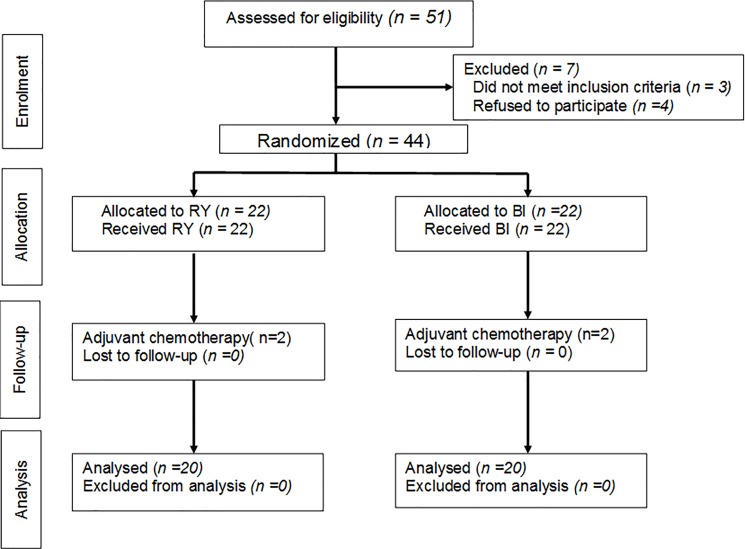
CONSORT diagram for trial.